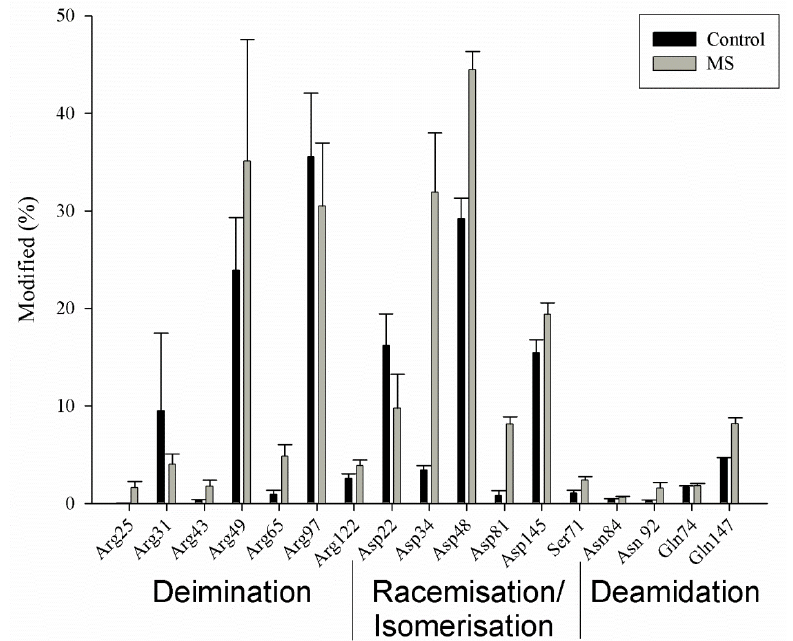
Figure 2. Myelin basic protein is highly modified in the adult human brain. Histogram showing the relative abundances of some of the major sites of modification in MBP from the cerebellum in controls and patients with MS. Three main types of modifications were observed: deimination of Arg (to form citrulline), racemisation and isomerisation of Asp, and deamidation of Asn and Gln. It should be noted that each site of Asn/Gln deamidation contains four Asp/Glu isomers due to the process of spontaneous racemisation and isomerisation (see Figure 1). The average ages of the two groups were controls 46 ± 22 years ( n = 10) and MS patients 60 ± 12 years ( n = 8). Shown are mean values ± SD. Detailed subject data from Friedrich et al., 2016 [9].